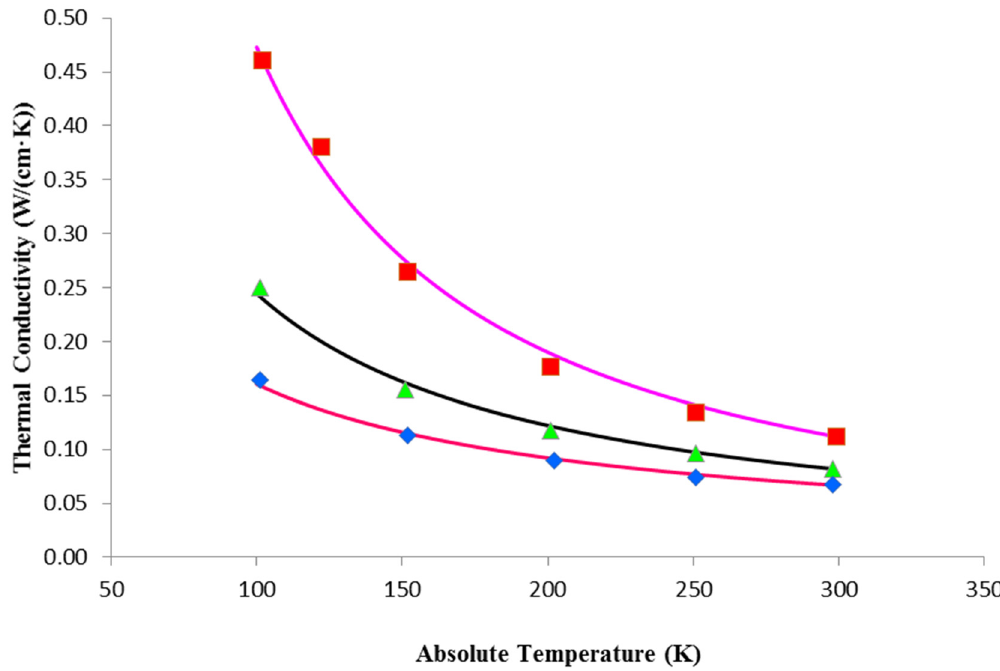
Figure 7. Thermal conductivity of undoped YAG (red), 4.0 (green) and 15.0 (blue) at. % Yb-doped YAG as a function of absolute temperature. Data are from [29]; also shown are fits to the data showing that the undoped case scales as b = 1.315 (pink), the 4.0 at. % Yb case (black) scales as b = 1, and the 15 at. % Yb case (orange) scales as b = 0.8.